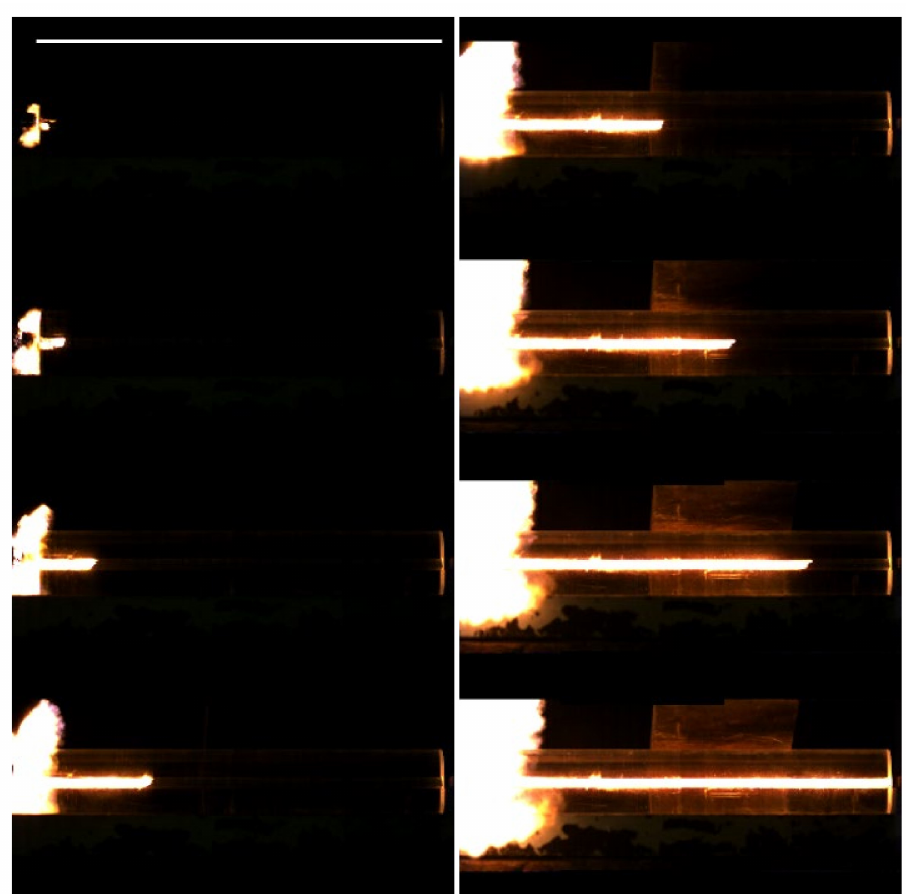
Figure 3. Photographs extracted from the combustion video of the Al/ITO_nm energetic composite material. The equivalence ratio ( φ ) was fixed at 1.2. The elapsed time between images was 40 µ sec. The white scale bar (on top on first) represents the tube length (150